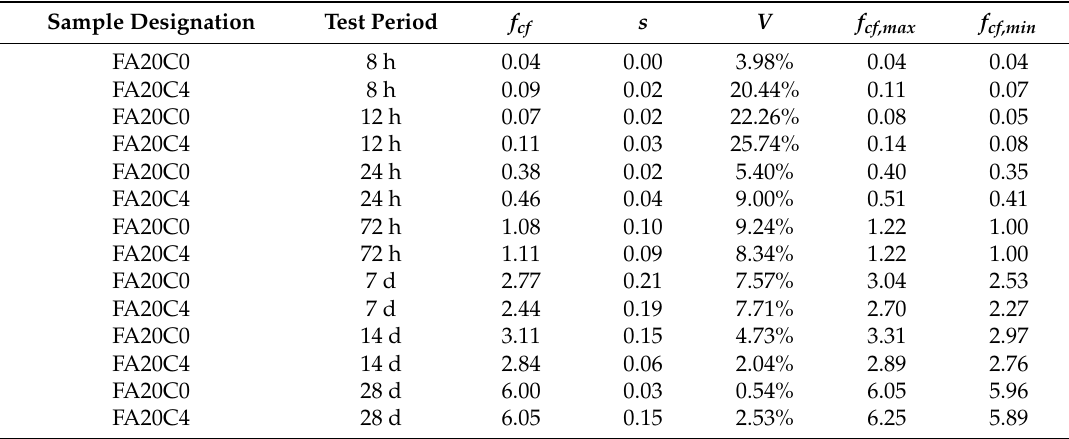
Table 6. Detailed results for the bending tensile strength test.